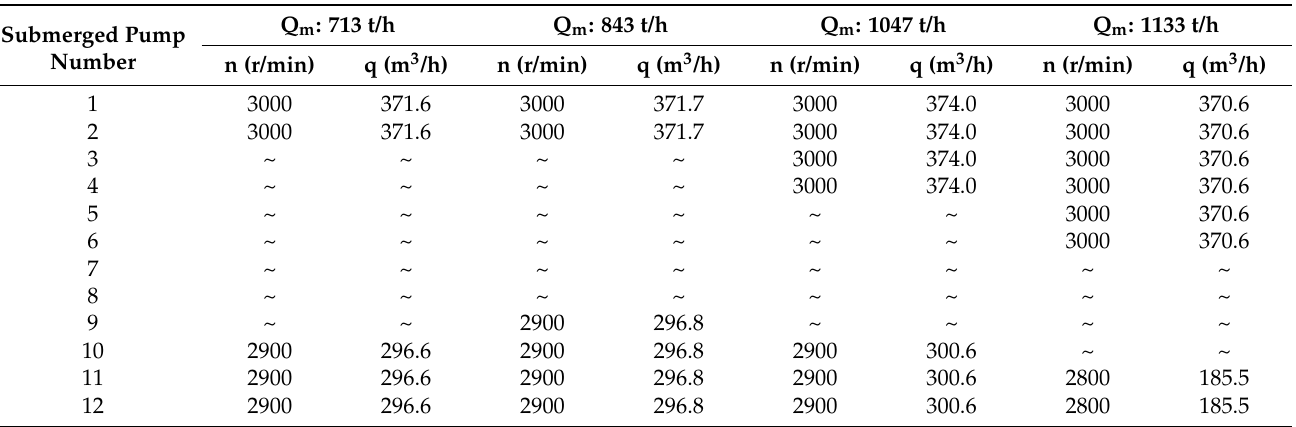
Table 3. Optimized operation plan of LNG submerged pump system under different external transportation flow.